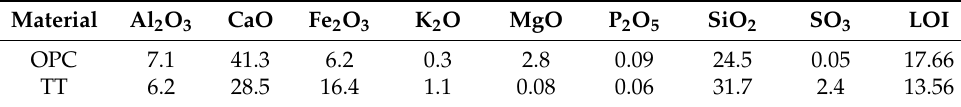
Table 1. Chemical compositions of OPC and TT (wt%).